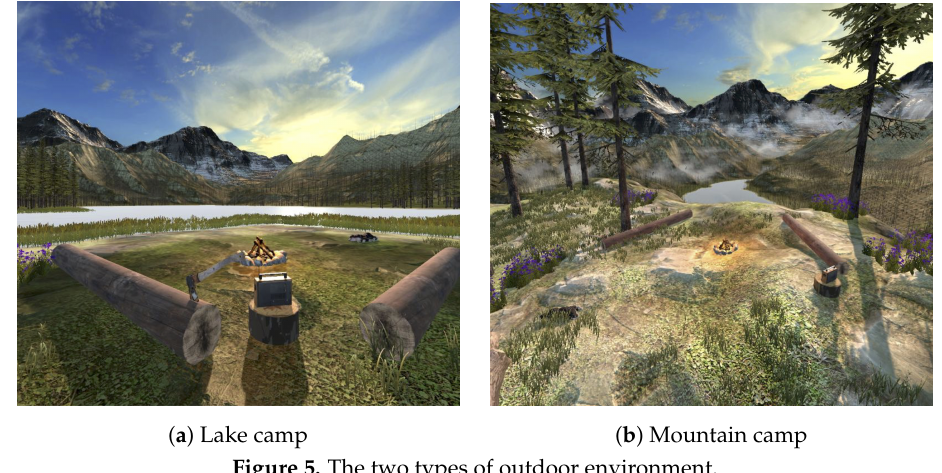
Figure 5. The two types of outdoor environment. Table 1. Summary of all possible adaptations implemented in the